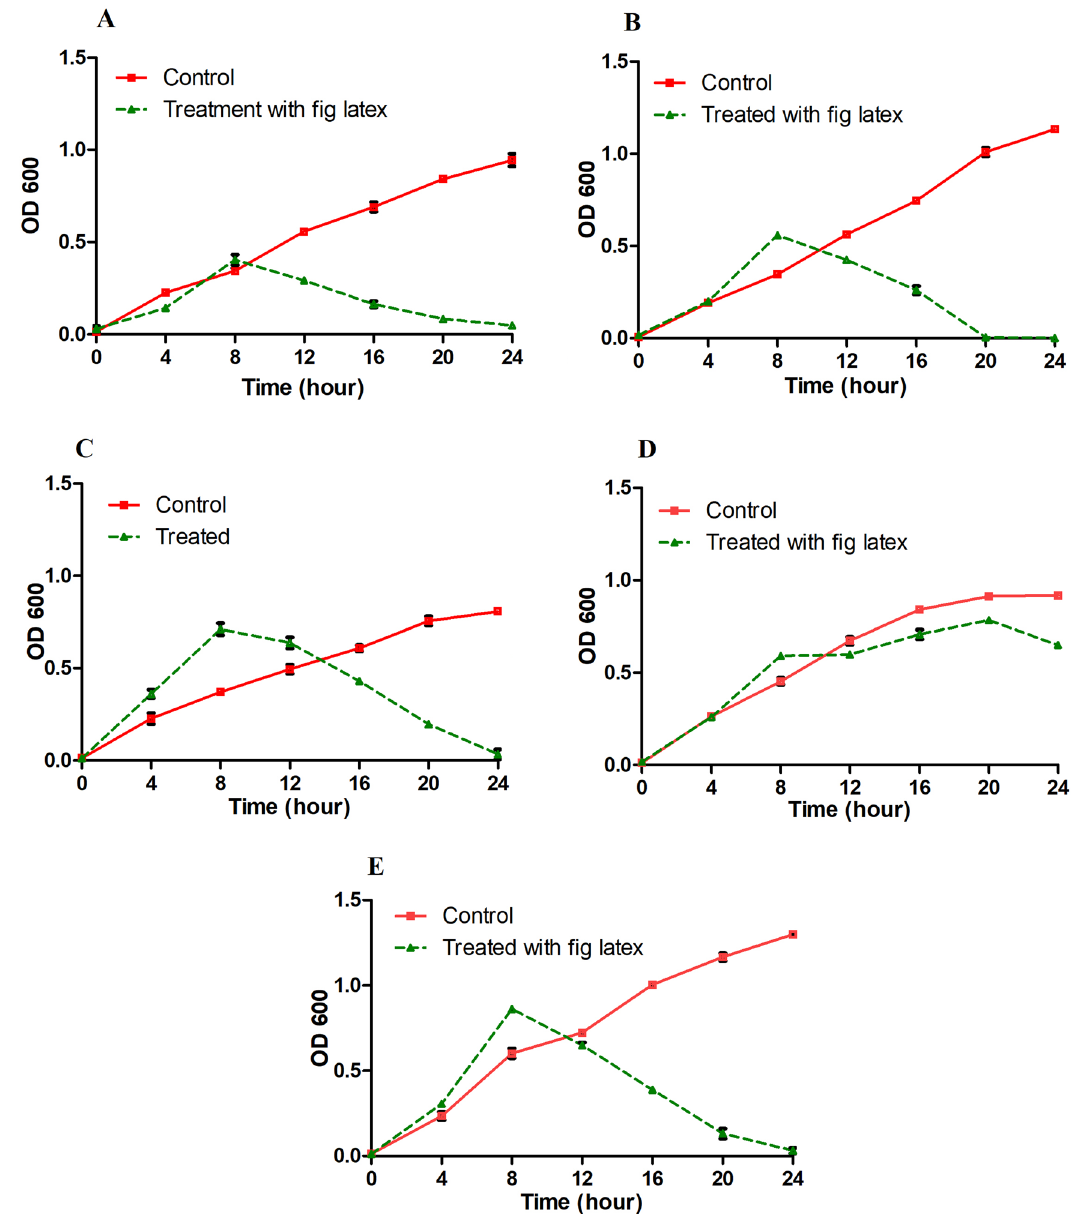
Figure 5. Survival curve of DFU pathogenic bacteria in the presence of fresh fig crude latex. The curves represent the bacterial isolates supplemented with the MIC of fresh fig latex in TSB media (dashed line) and show a significant decrease in OD600 for ( A ) Paenibacillus sp., ( B ) Bacillus sp., ( C ) Pseudomonas sp. MS2, and ( E ) Staphylococcus haemolyticus AUMC B-331 but not for ( D ) Pseudomonas sp. MS4. The curves represent the bacterial isolates in TSB media without latex (solid line) and show an increase in OD at 600 nm. The results are the mean from triplicate independent